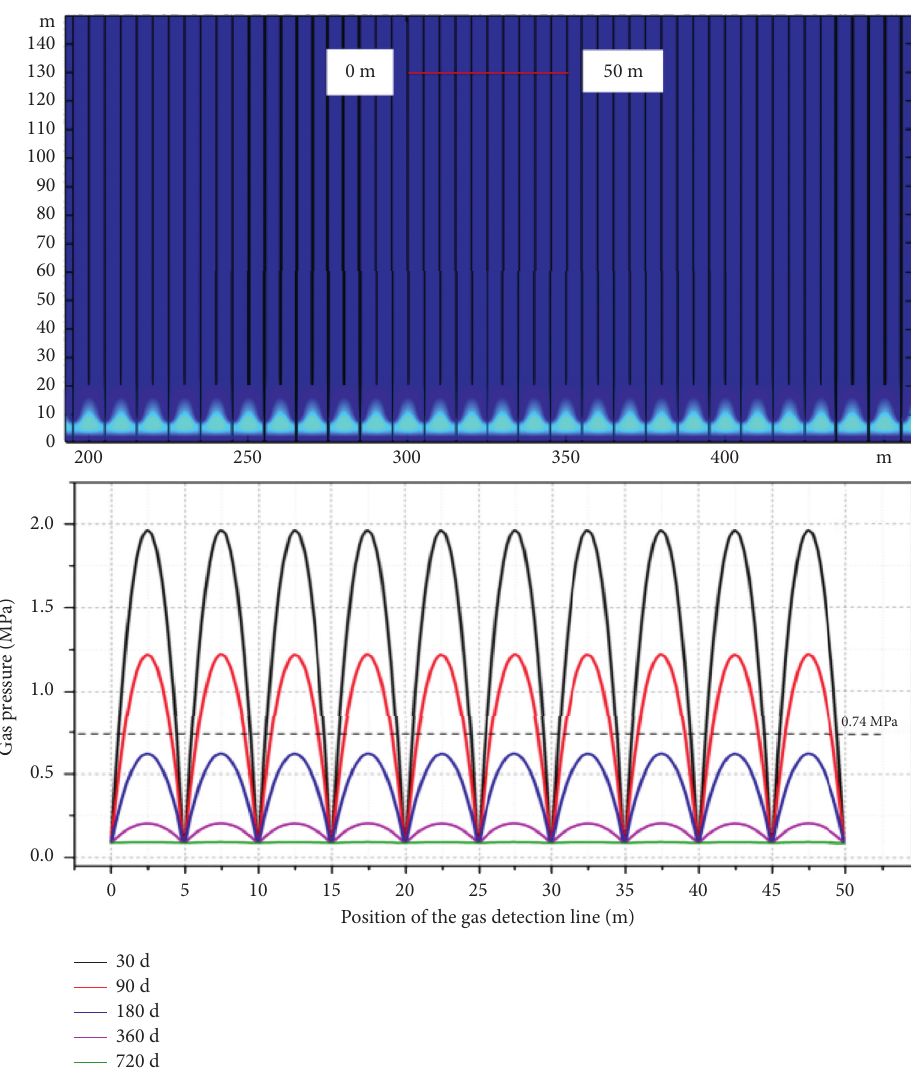
Figure 4: Gas pressure changes at different extraction times.